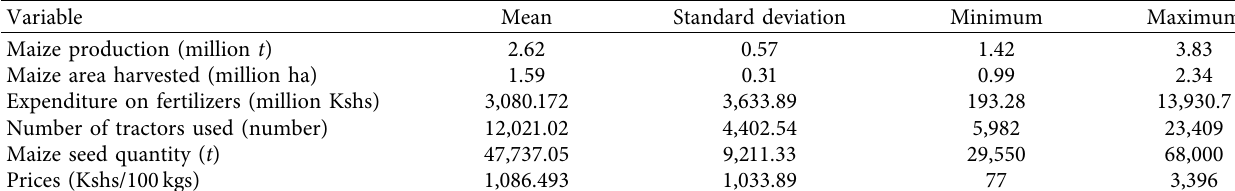
Table 1: Summary statistics (number of observations 41 years, from 1976 to